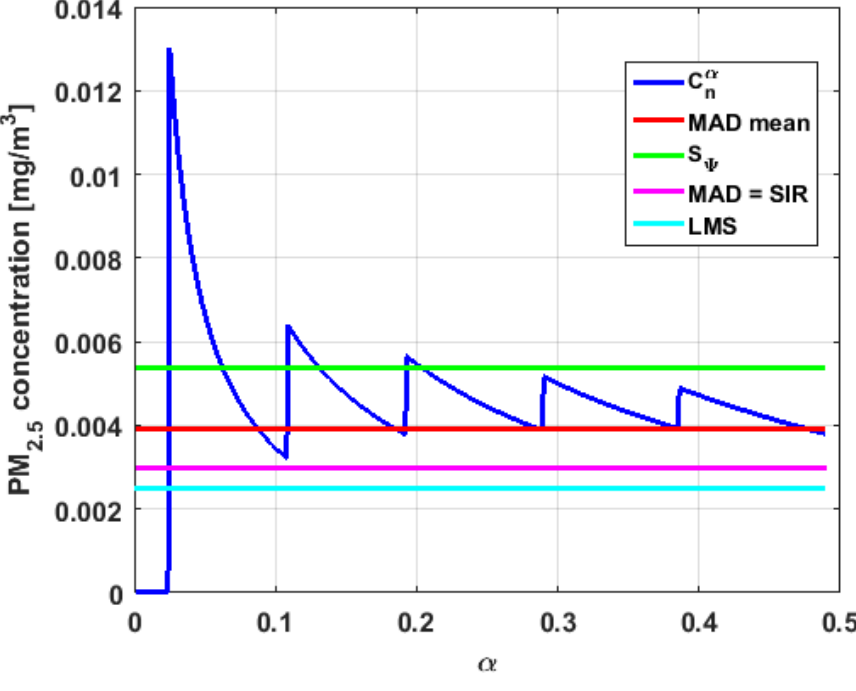
Figure 30. 𝐶 𝑛𝛼 estimates of 𝑋 2 . Figure 30. C α n estimates of X 2 .